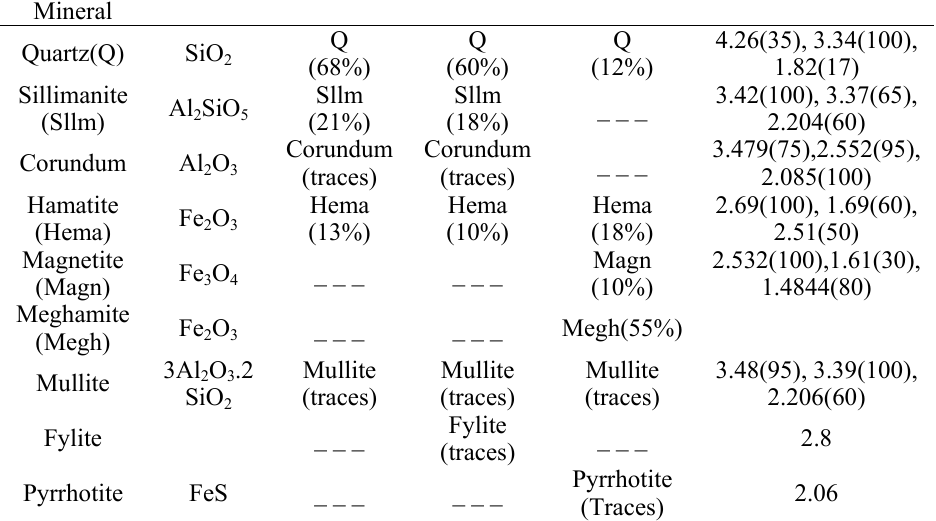
Table 1. Minerals found in fly ash before and after gravitational separation and their characteristics d value